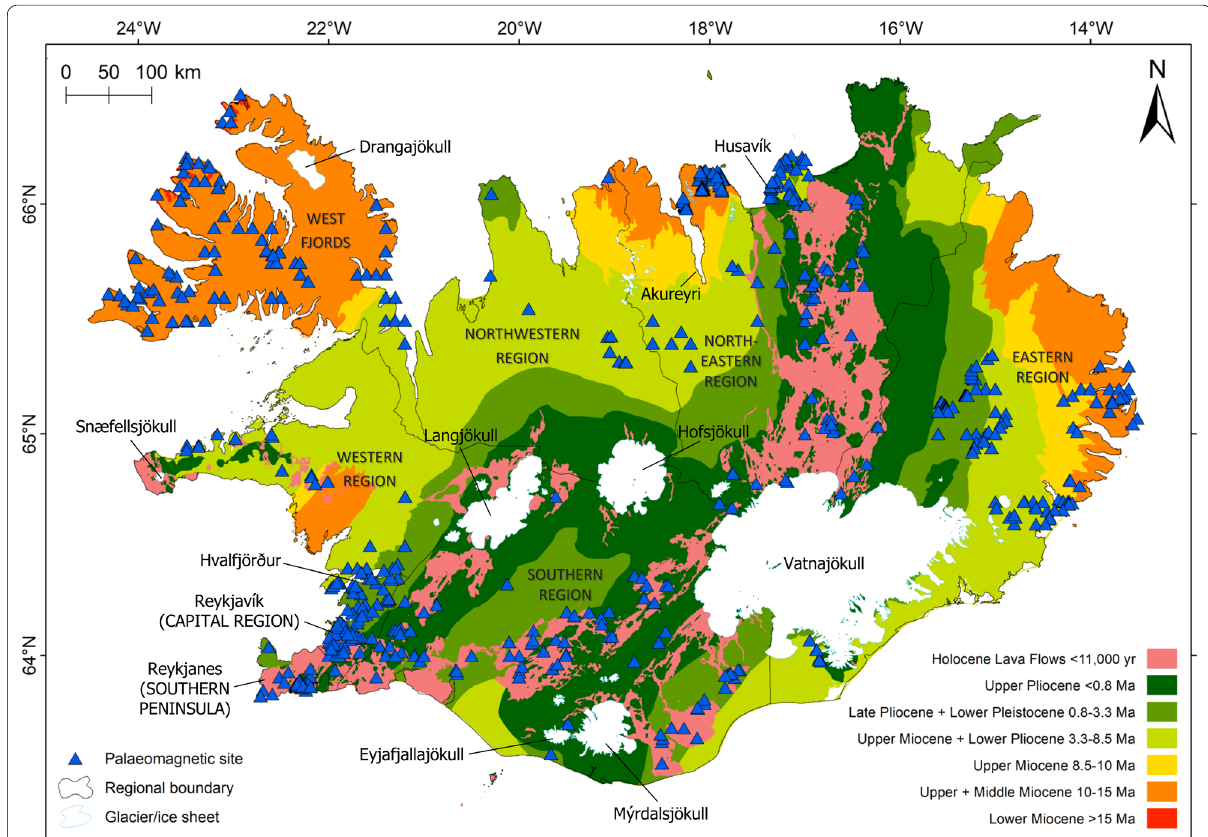
Fig. 1 Map of ICEPMAG sites with bedrock geology and regional boundaries. All ICEPMAG sampling site locations. Regional boundaries defined by country subdivision code ISO 3166‑2:2013. Tectonic geology map adapted from Jóhannesson and Sæmundsson (2009) based on data publicly available from The Icelandic Institute of Natural History (open license: http://www.ni.is/ranns oknir /landu pplys ingar /skilm